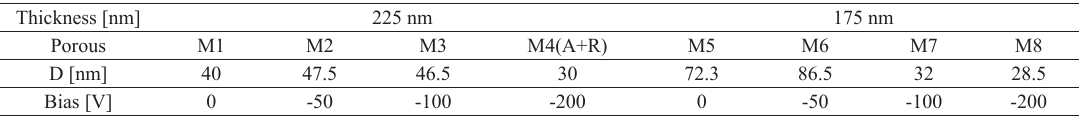
/BL deduced by (101) anatase plane reflections 2